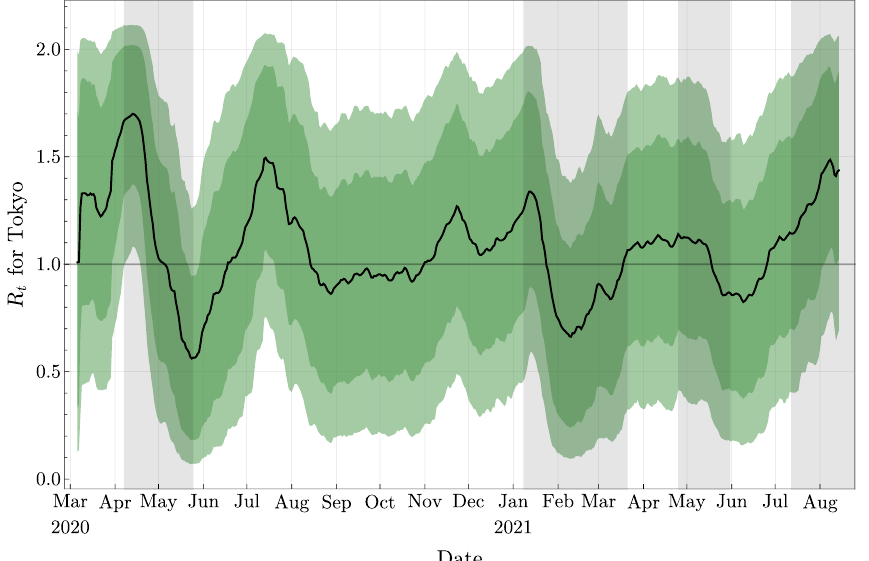
Figure 1. Effective reproduction number. The black curve indicates the mean value obtained from numerous independent simulations; the dark and light colored regions refer to the 68% and 90% confidence intervals, respectively. States of emergency correspond to grey